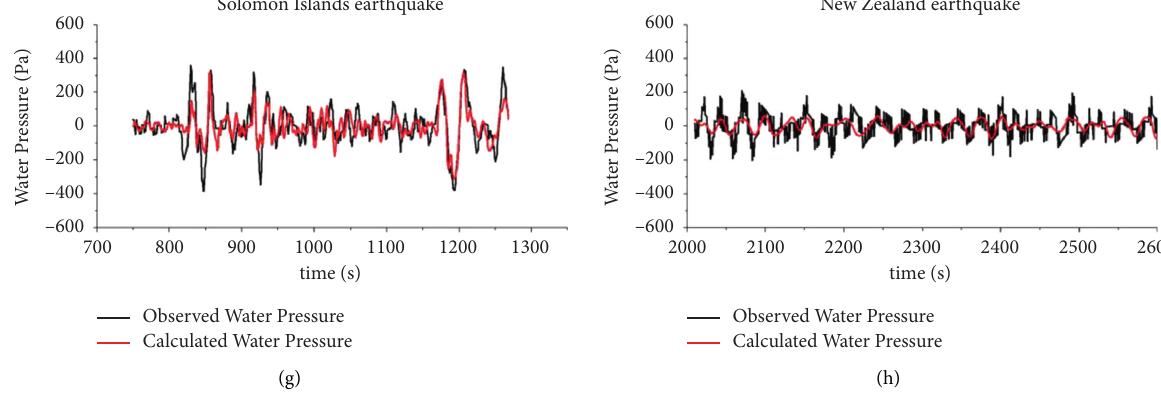
Figure 3: Calculated and observed water pressure in X10 in response to Solomon Islands earthquake and Kaik � oura earthquake: (a, b) assuming only volumetric strain; (c, d) assuming only deviatoric strain; (e, f) assuming both volumetric strain and deviatoric strain for surface waves; (g, h) assuming both volumetric strain and deviatoric strain for body waves.